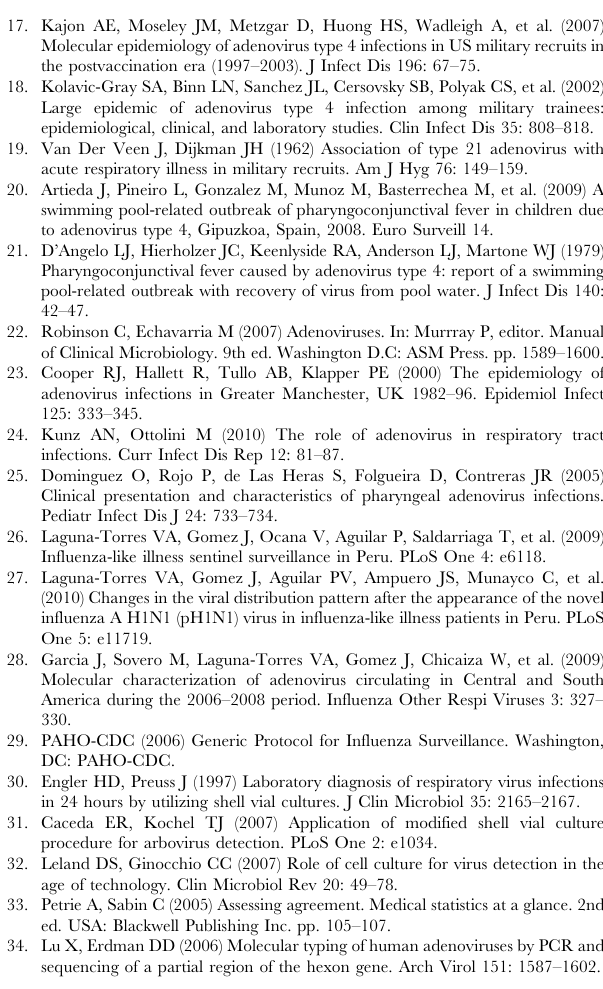
Figure S1 Age distribution of children younger than 15 years diagnosed with HAdv, seasonal influenza A virus, influenza B virus, influenza A (H1N1) pdm09 virus, parainfluenza virus, and respiratory syncytial virus (RSV) infections. Peru, 2000–2010. Figure S2 Box-and-whisker plot of age (years) around the median age (horizontal line) for each of the viruses isolated. Only participants with one virus detected were evaluated in this analysis. Boxes extend from 25–75th percentiles. Whiskers extend to the largest and smallest observed values in the distribution which fall within 1.5 times the box length around the median. Circles represent outlier